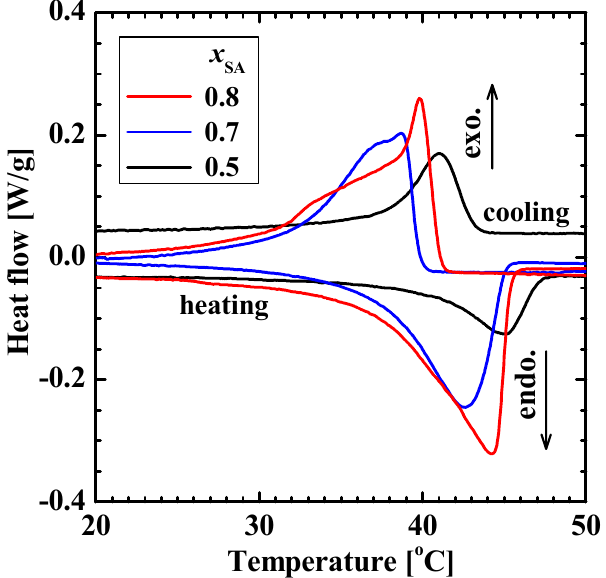
Figure 3. DSC thermograms of poly(SA- co -MPGA) hydrogels prepared with x SA = 0.5, 0.7, and 0.8.